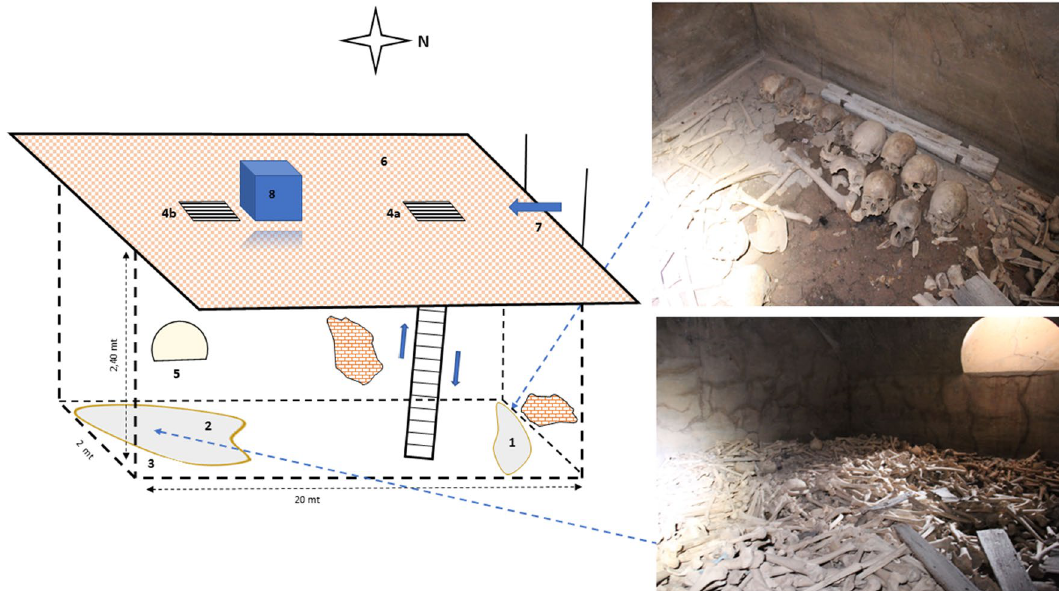
Figure 1. Axonometric projection of the charnel house of the Villaputzu site. Schematic representation of the charnel house used as a sampling site of historical dental calcoli : 1 pile of skeletal material in the recovery stratum; 2 walking surface; 3 buried muddy stratum; 4a NW trapdoor; 4b SE trapdoor; 5 air ducts; 6 church floor; 7 church gate; 8 altar church; x = sample recovery spot. Drawn by G.